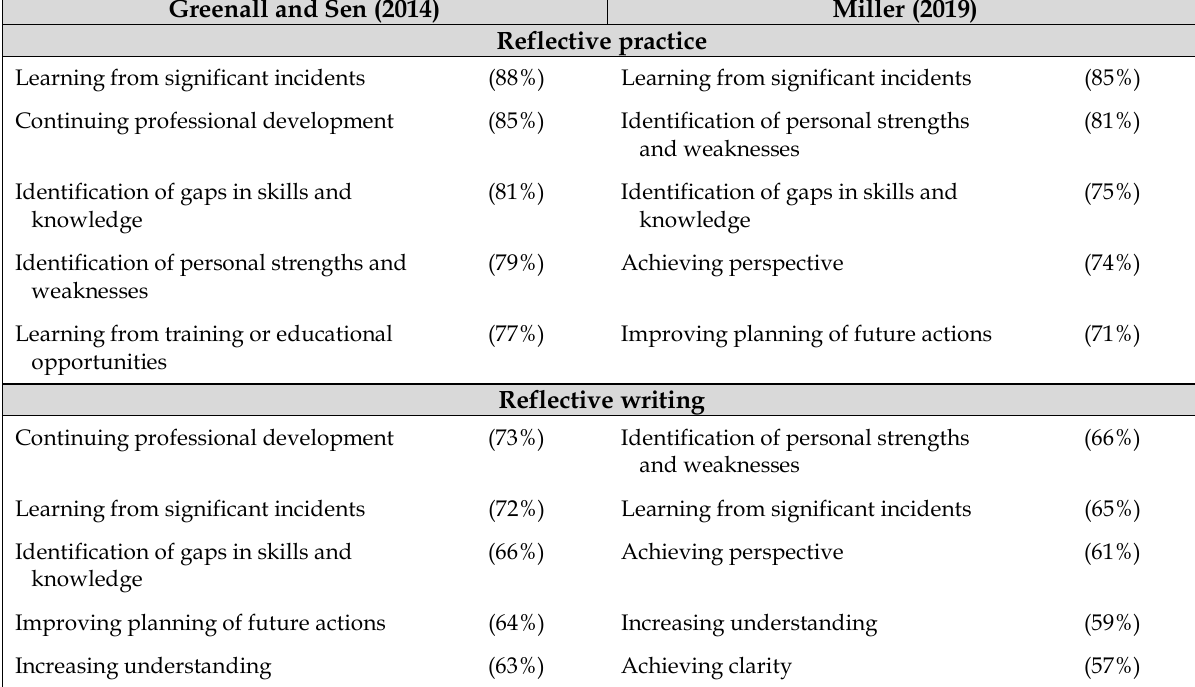
Table 3 Most commonly selected benefits of reflective practice and writing Greenall and Sen